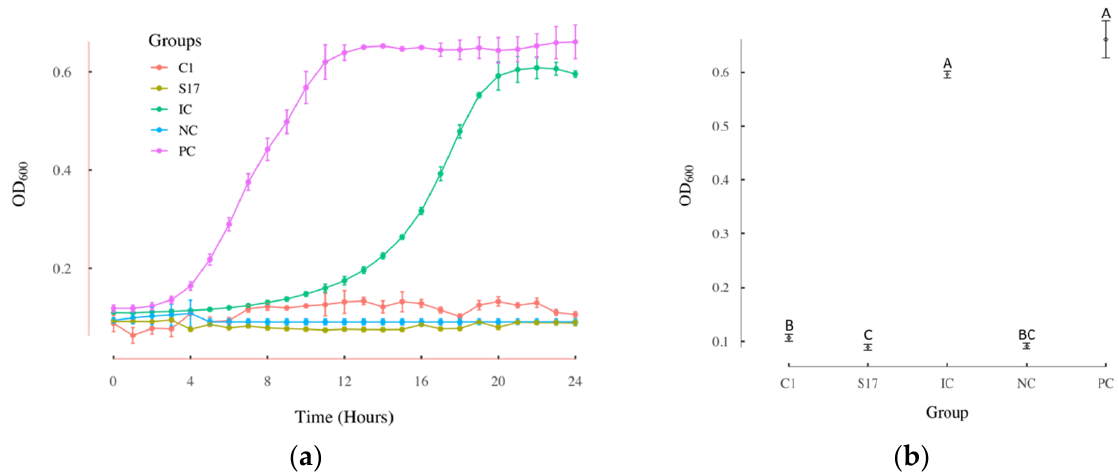
Figure 2. Compounds effective in growth inhibition assay using L. innocua . ( a ) The growth curves of L. innocua over 24 h under different treatment conditions; ( b ) the OD 600 values of L. innocua at 24 h under different treatment conditions. ANOVA revealed significant differences among the different groups (F 4,10 = 972.8, p = 6.63 × 10 −13 ). The results of the Kruskal–Wallis test are represented with letters (different capital letters = significantly different groups); PC: positive control group; NC: negative control group; IC: the known inhibitor fosfomycin 0.5 mg/mL group; C1: 2-[4-(dimethylamino) benzylidene]- N -nitrohydrazinecarboximidamide 0.5 mg/mL group; S17: 2-amino-5-bromobenzimidazole 0.5 mg/mL group; OD 600 : the absorbance at 600 nm; n = 3; error bars represent standard deviations.